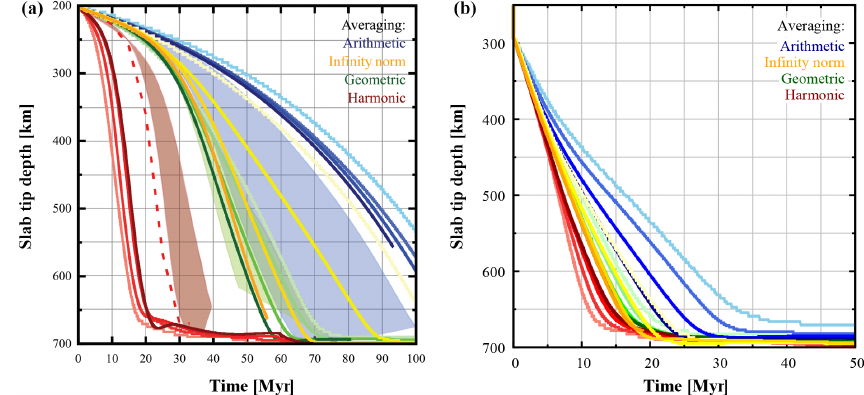
Figure A2. Slab tip depth versus model time for four different averaging methods of the contribution of the compositional fields to viscosity. Colors indicate the averaging method, while one color goes from light to dark with local resolution, which varies from 256 × 64 elements to 2048 × 512 elements. Minimum resolution is always 128 × 32 elements. (a) Case 1. The dashed red line model has a resolution varying from 128 × 128 to 2048 × 2048 elements. Shaded areas represent results of Schmeling et al. (2008, Fig. 6). (b) Case 2.